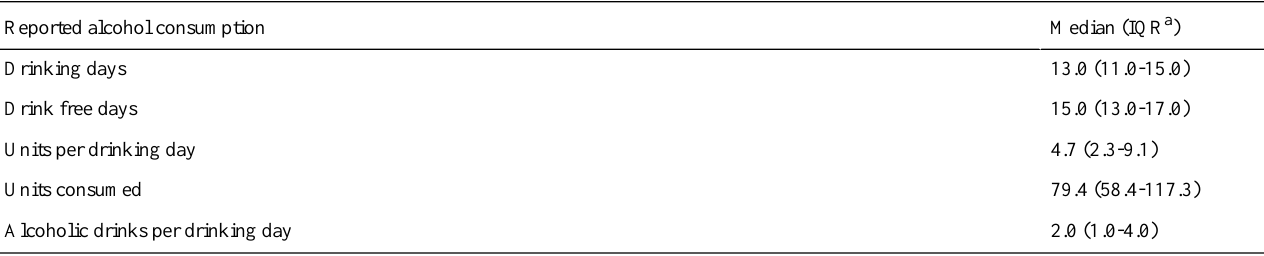
Table 4. Number of drinking days, drink free days, units consumed, and alcoholic drinks per drinking day across the study period (4 weeks, n=31).